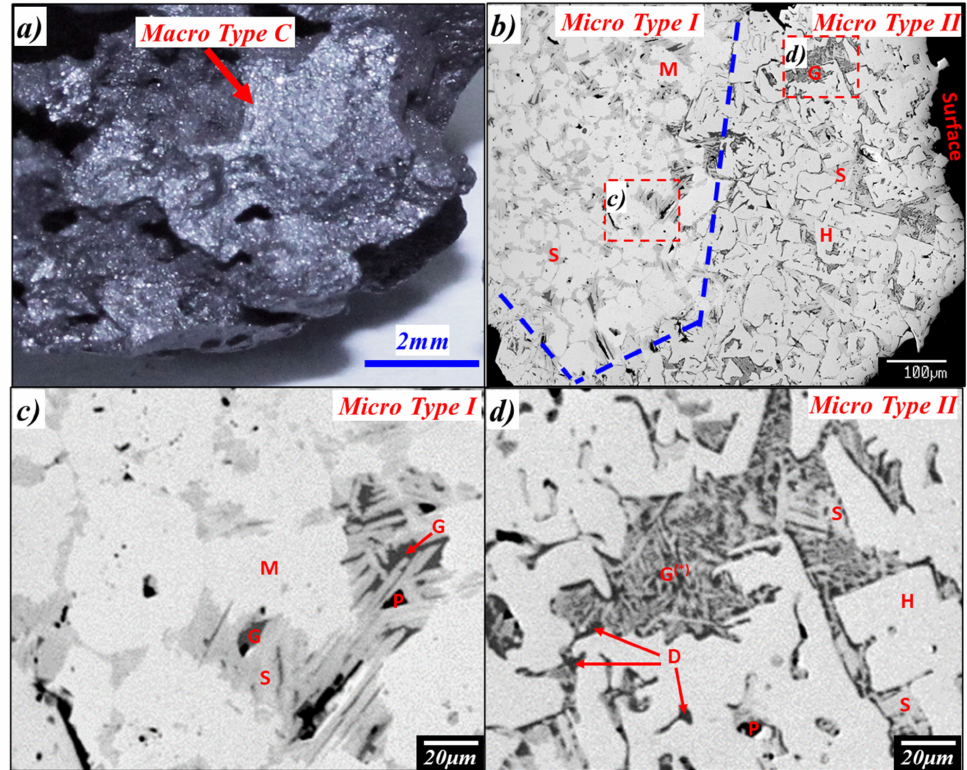
Figure 6. ( a ) Details of macro-features of type C (shiny/fractured, dense surface) taken by digital camera; ( b ) backscattered electron image of microstructures in Macro-Type C; ( c ) and ( d ) details from different locations of ( b ), G = Glass; H = Hematite; M = Magnetite; S = SFCA solid solution; D = Dicalcium silicate (C 2 S); P = Pores, (*) microcrystalline material, formerly liquid slag. Macro-Type D has a fractured, porous surface (mm to cm-scale diameter pores), is shiny and light-reflective, grey in colour and also relatively weak in strength compared to Types A and B. This is the region with locally low mechanical endurance and subsequently fractured (similar to Macro-Type C). The microstructures in Type D (Figure 7b–d) areas are like those of Type C, where a layer of Type II (glass + euhedral hematite + minor fine SFCA + C 2 S, Figure 7c) is found on the surface layer of the bulk Type I structure (Figure 7d). The major difference between Types C and D is the high proportion of mm-sized pores in Type